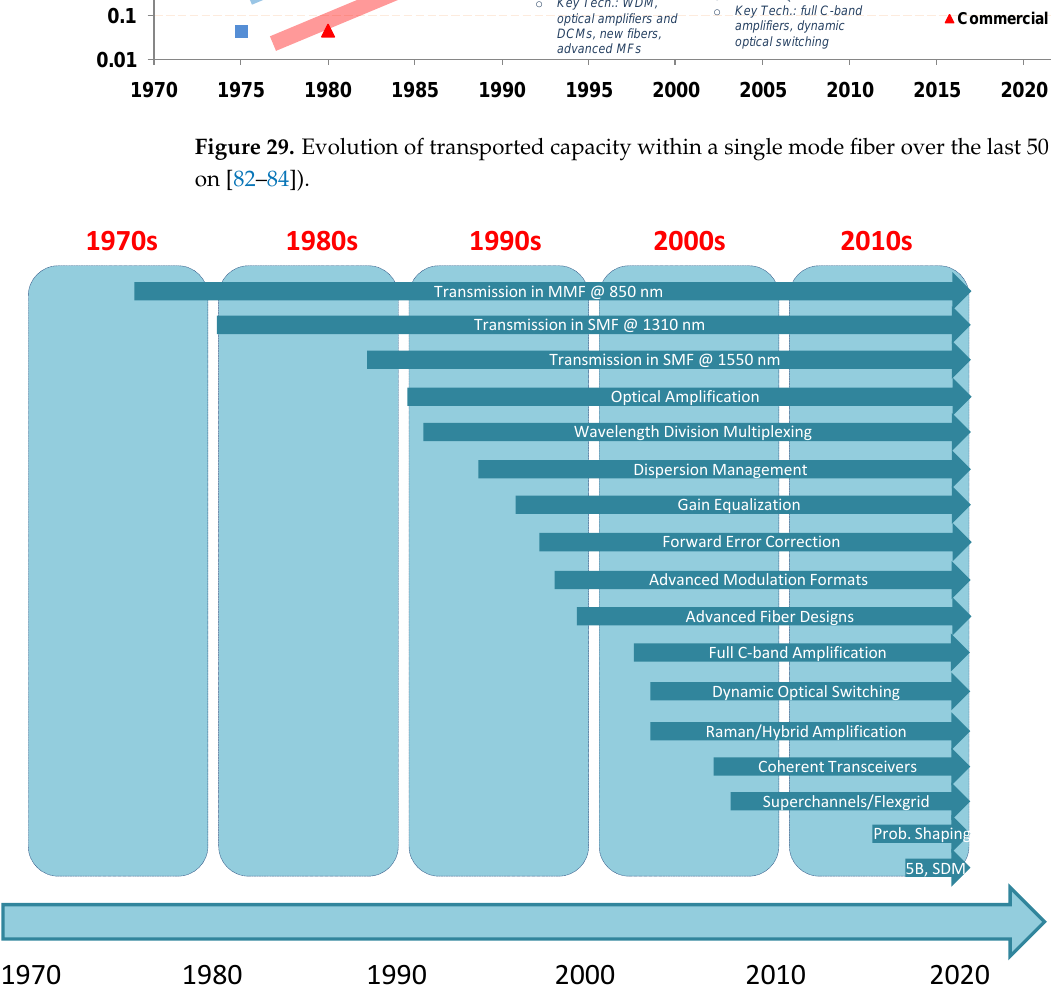
Figure 30. Overview of the key technological advances which allowed to increase the B x L product in optical transmission.